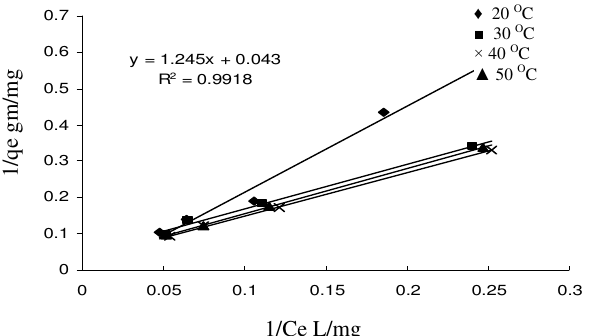
Figure 2. Langmuir plot for the adsorption of Cr(VI ), 20, 30, 40 and 50 mg / L onto cinnamon